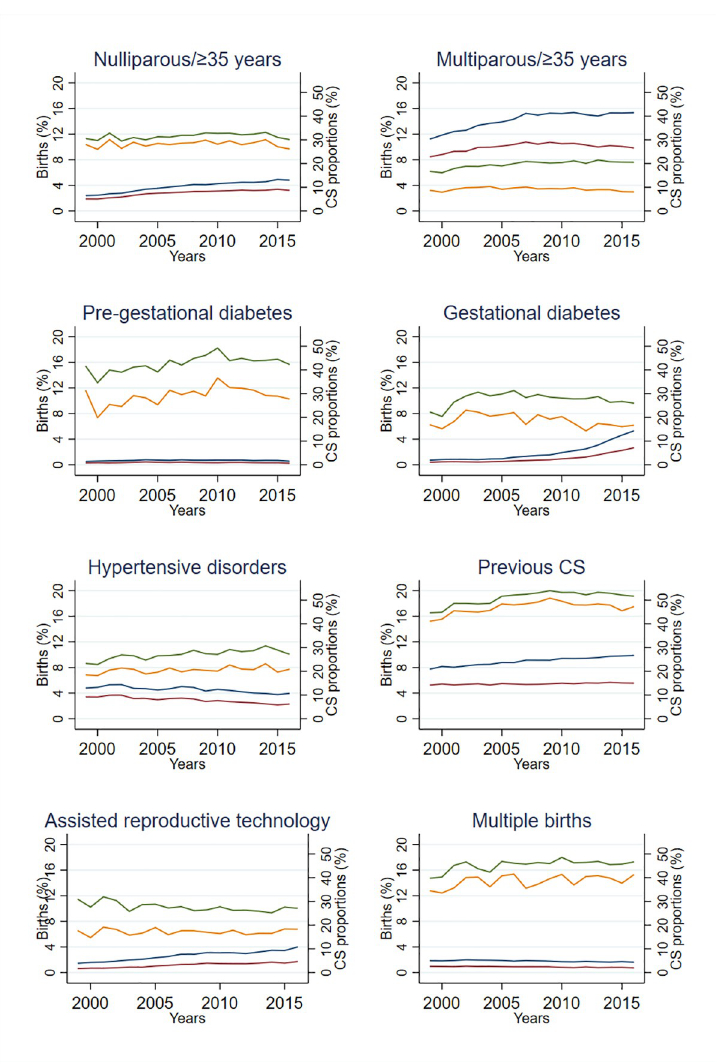
Fig 3. Each risk factor by proportion of births and corresponding CS births, by year 1999–2016 (%). Proportion of births with a single risk factor (red). Proportion of births with a single risk factor in combination with any other risk factor (blue). Proportion of CS births with a single risk factor (yellow). Proportion of CS births with a single risk factor in combination with any other risk factor (green). CS, cesarean